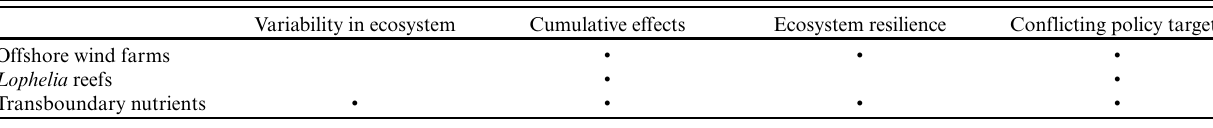
Table 2 . Critical issues found within each case